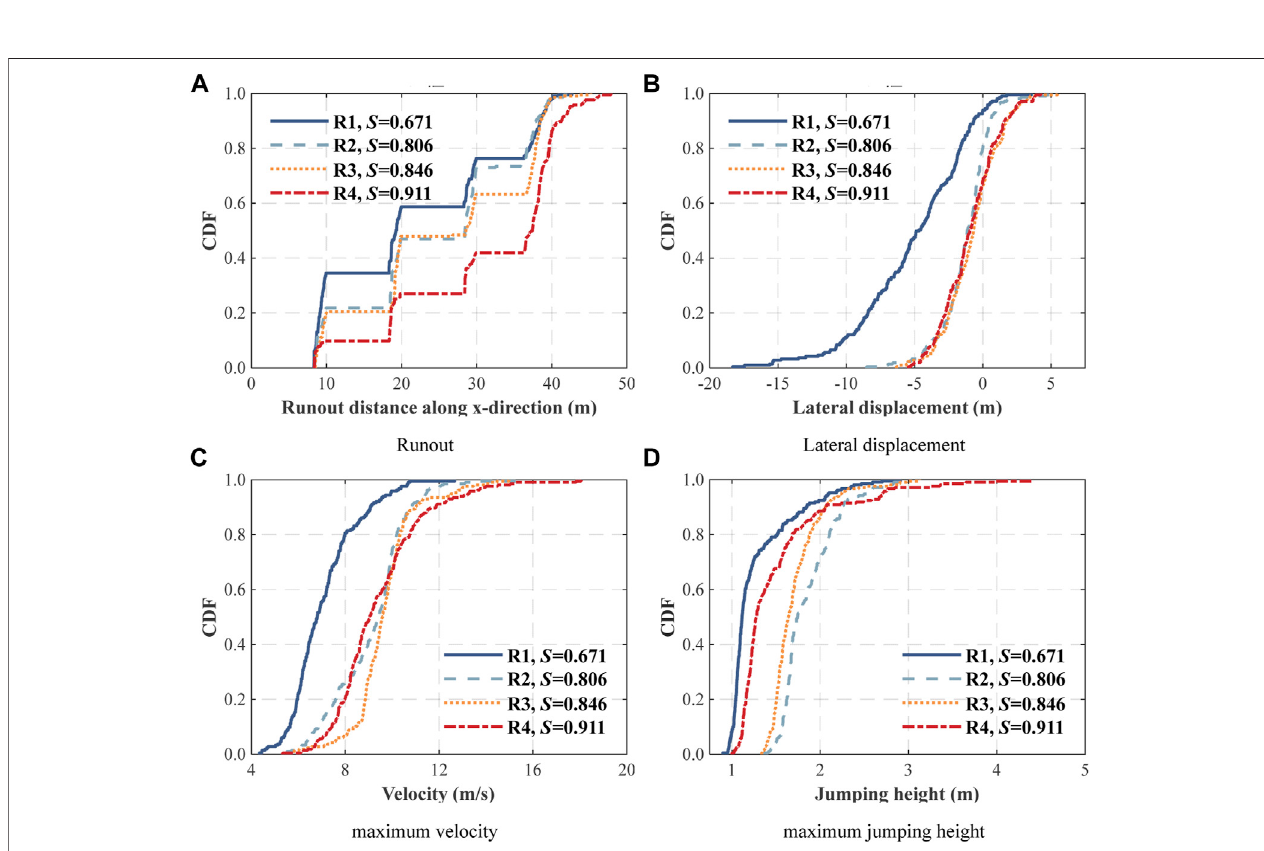
Frontiers in Earth Science |